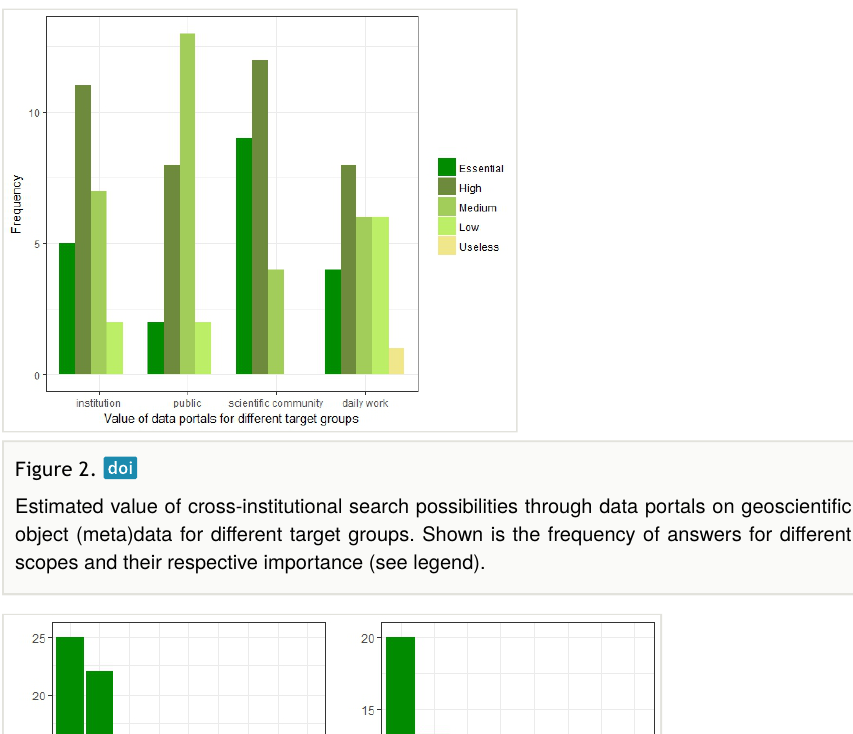
Reasons for publication of (meta)data on geoscienti fi c collection objects (a) and not publishing particular datasets through a data portal (b). Shown is the frequency of answers per reason. Note that the y-axes are scaled di ff